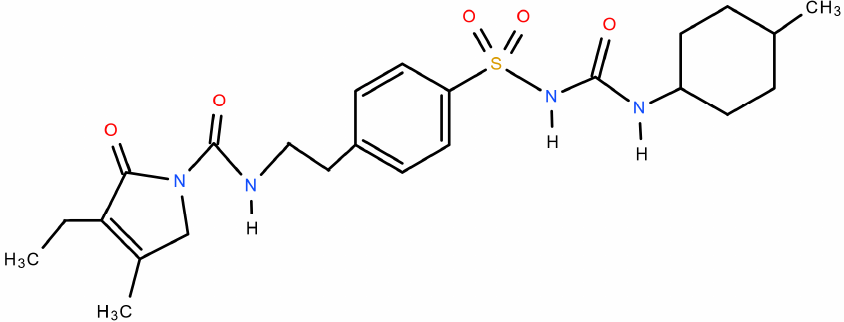
Figure 1. Chemical structure of glimepiride.